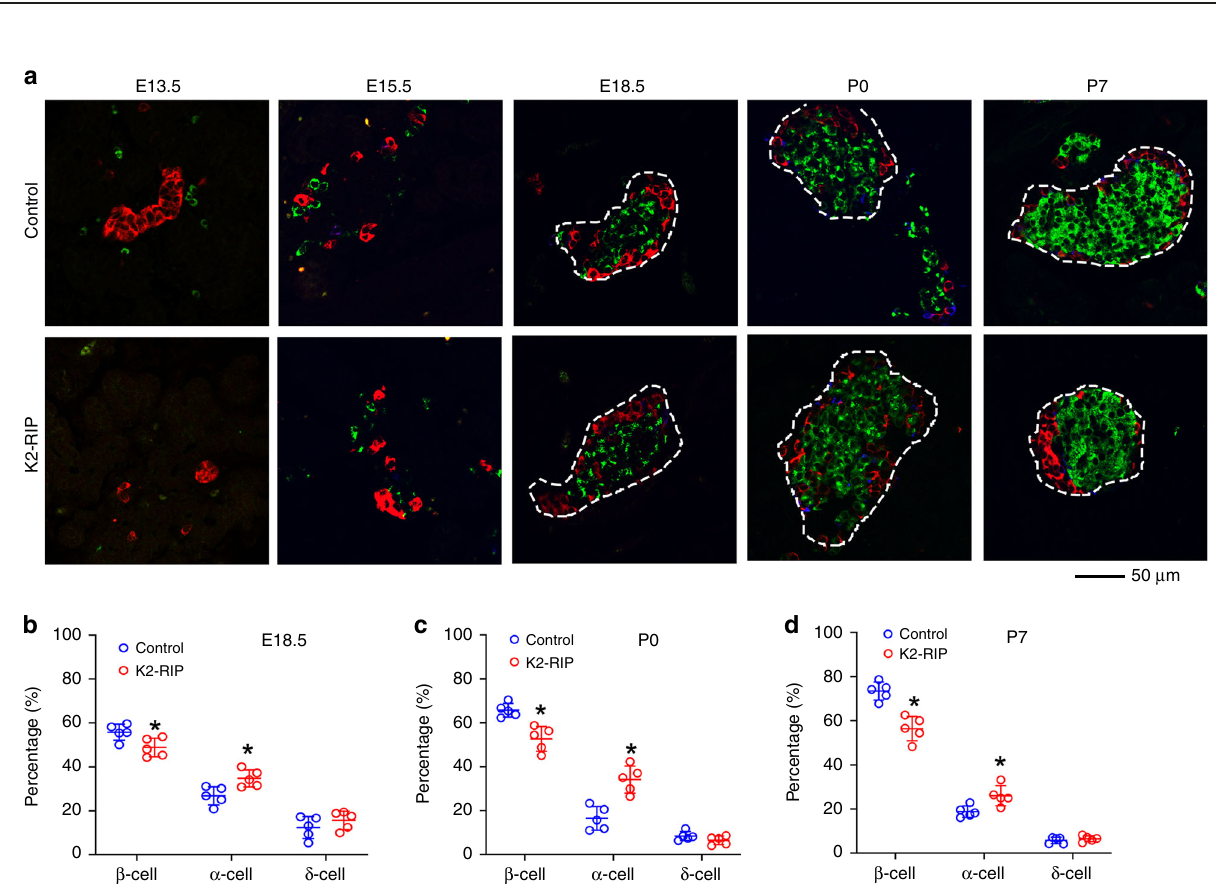
Fig. 3 Kindlin-2 loss activates GSK-3 β and reduces β -catenin expression and β -cell proliferation and mass. a , b Pancreatic sections from 1-week- or 2- month-old male control ( RIP-Cre ) and K2-RIP mice were subjected to IF staining for insulin, followed by measurements of β -cell area/pancreatic area ratio ( a ) and β -cell mass ( b ). * P < 0.05, versus control, N = 5 for 2-month-old K2-RIP in a , N = 6 for the remaining groups, Student ’ s t test. c , d Cell proliferation. Sections of 1-week-old control and mutant male pancreas were double stained with antibodies against insulin and Ki67 ( c ). Ki67-positive cells in islets were normalized to total insulin-positive cells in the same area ( d ). Around 444 – 816 β -cells (insulin-positive cells) per mouse were counted. N = 4 mice per genotype. Scale bar, 20 μ m. * P < 0.05, versus control, Student ’ s t test. e qPCR analyses. Total RNAs isolated from islets of 1-week-old K2-RIP and control littermates were subjected to qPCR analysis for the indicated genes. mRNA levels were normalized to Gapdh mRNA. Statistical analyses (Student ’ s t test) were performed using the average values of triplicates from three independent experiments. * P < 0.05, versus control. f , g Western blot analysis. Protein extracts isolated from islets isolated from K2-RIP mice and control littermates ( RIP-Cre ) were subjected to Western blot analyses with indicated antibodies. Quantitative data from three independent experiments ( g ). * P < 0.05, versus control, Student ’ s t test. h IHC staining of pancreatic sections with antibodies against phospho-GKS-3 β (Ser9) (top) and total GSK-3 β (bottom). Scale bar, 50 μ m. i , j Western blotting. Human pancreatic islets were infected with or without Kindlin-2 shRNA (Sh-K2) or control (Sh-con) lentiviruses, followed by Western blot analyses with indicated antibodies. Quantitative data from three independent experiments ( j ). * P < 0.05, versus control (Sh-con), Student ’ s t test. k IHC staining of pancreatic sections of 3-month-old db/db mice and age- and sex-matched C57BL/6 (control) mice with indicated antibodies. N = 3 mice per genotypes. Scale bar, 50 μ m. Results are expressed as mean